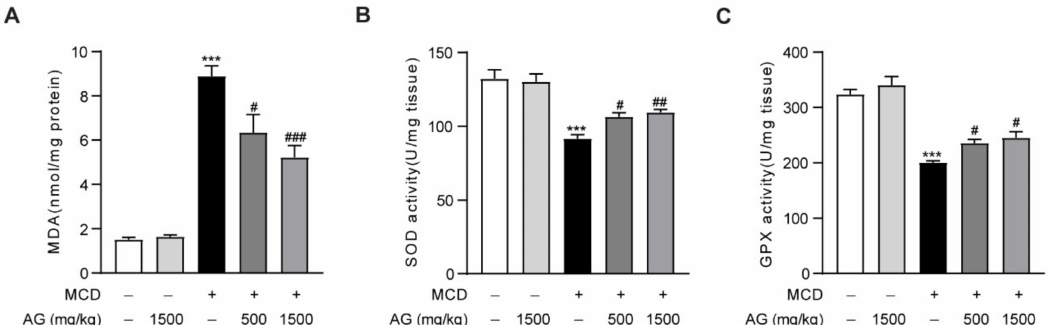
Figure 3. Ala-Gln alleviates hepatic oxidative stress in NASH mice. ( A ) Hepatic MDA levels. ( B ) Hepatic SOD activities. ( C ) Hepatic GPX activities. Data are expressed as the mean ± SEM. *** p < 0.001, compared to the Ctrl group; # p < 0.05, ## p < 0.01, ### p < 0.001, compared to the Model